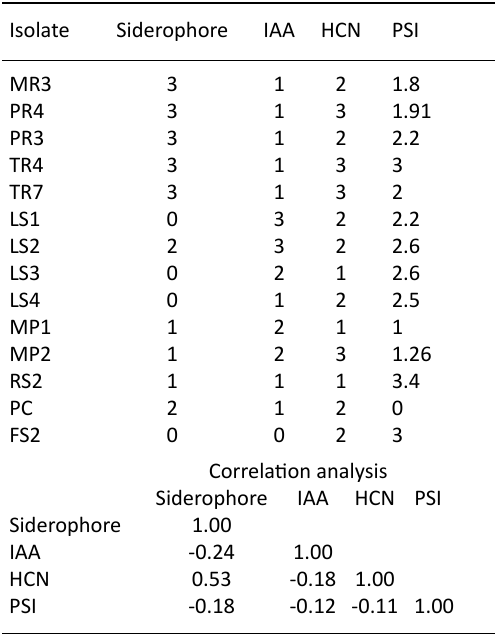
Table 1. Correlation analysis to indicate co-existence of P-solubilizing and multiple biocontrol traits in selected isolates Isolate